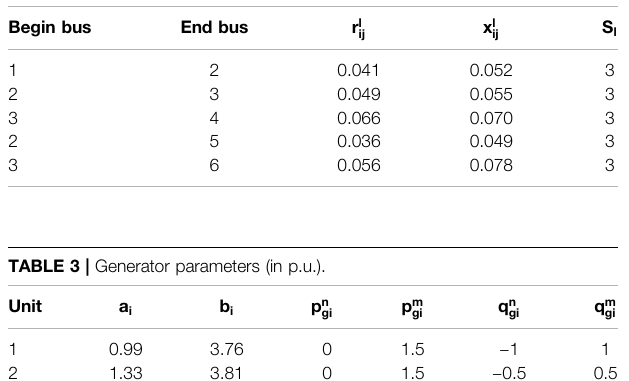
TABLE 1 | Production and consumption amount/kWh.